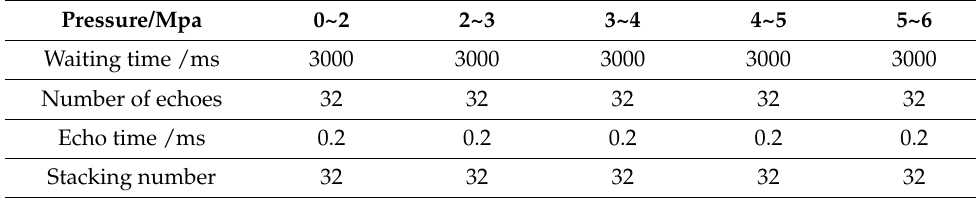
Table 5. NMR adsorption measurement parameters.